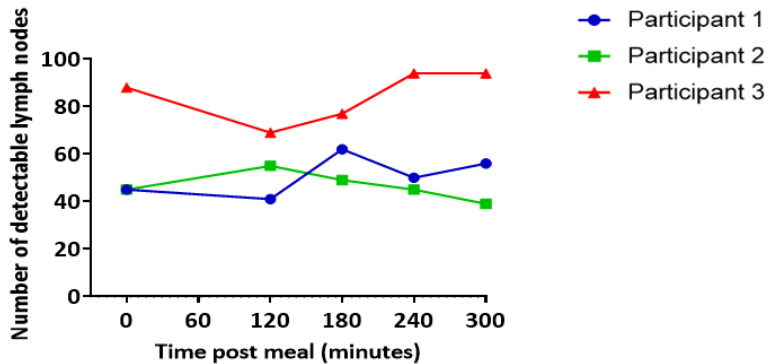
Figure 2. Number of lymph nodes visible at each scan. Data represent the combined total of nodes across all slices. Each line represents data from an individual participant.